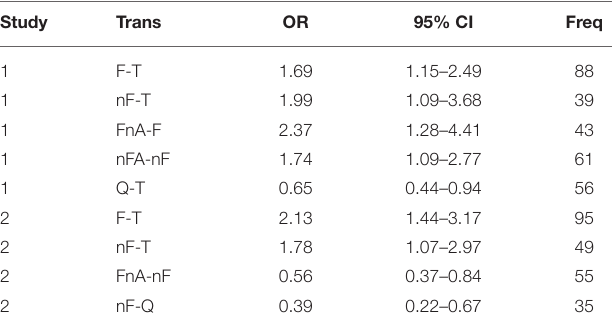
TABLE 4 | Discriminative Transitions by Study, with odds-ratio values, 95% confidence intervals and absolute frequency of occurrence.